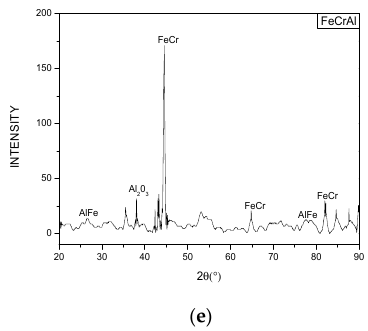
Figure 5. XRD patterns of the coatings ( a ) #A, ( b ) #B, ( c ) #C, ( d ) #D, and ( e ) FeCrAl.